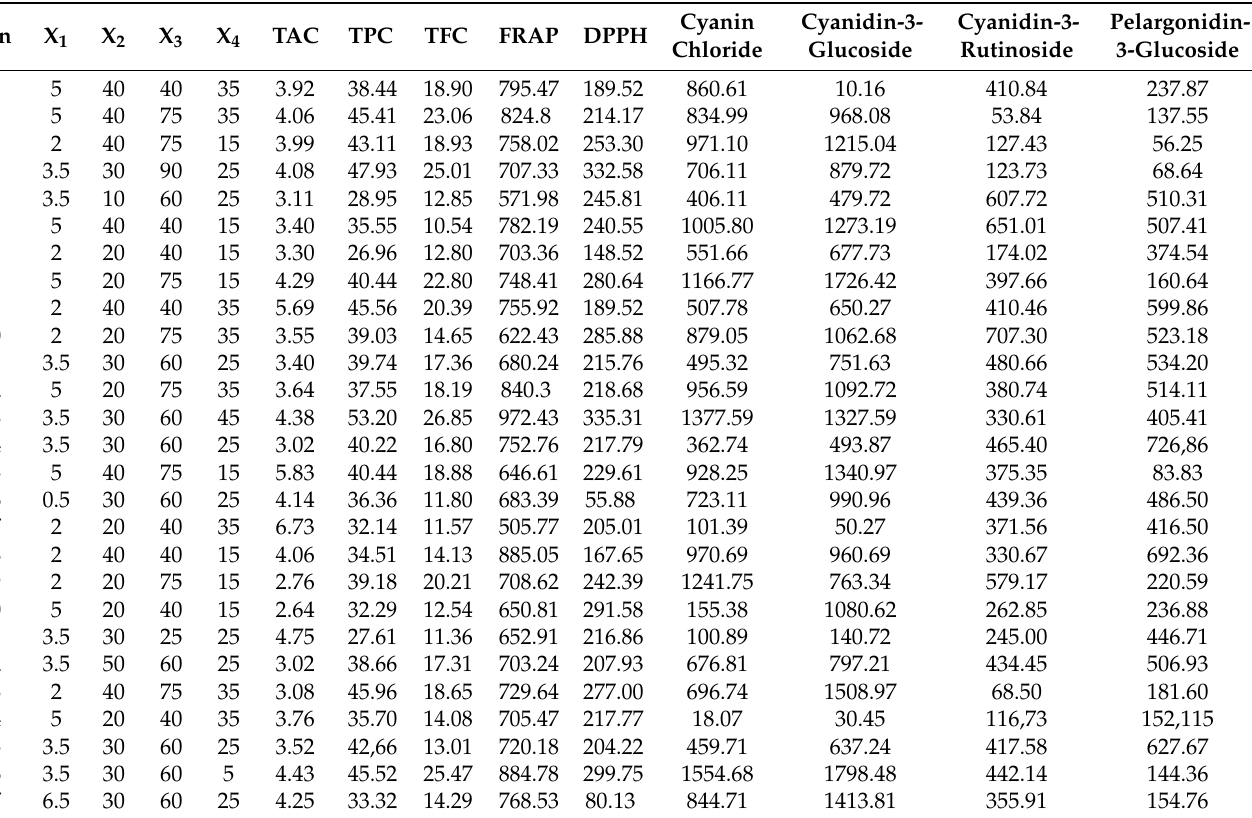
Table 2. Independent factors (X 1 , X 2 , X 3 , and X 4 ) and experimental results for the